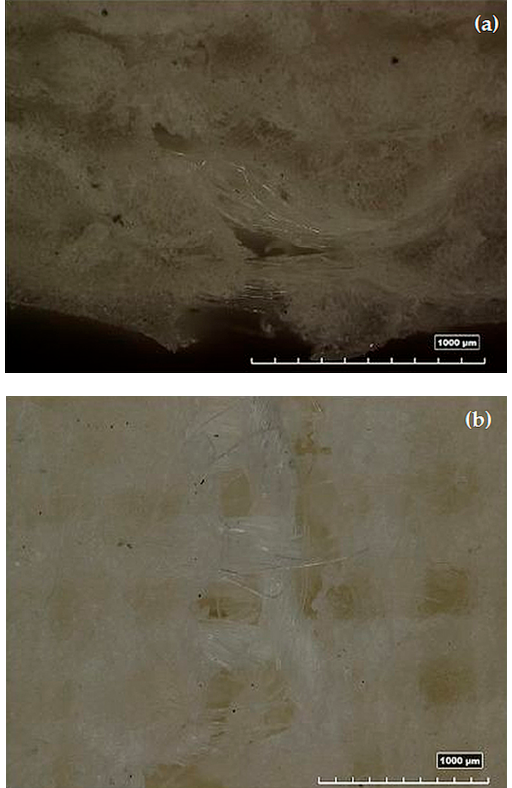
Figure 11. Images of the fracture for the tensile stress in the section ( a ) (140×) and in the plane ( b ) (100×) view. Table 5. Results from the three-point bending tests.